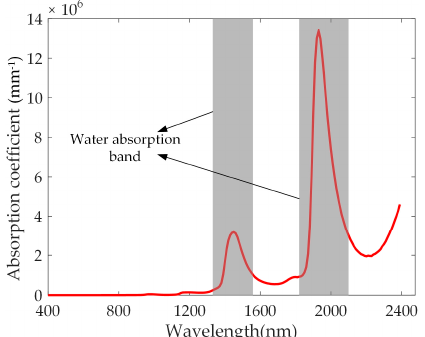
Figure 2. Absorption coefficient of pure water [43,44] .